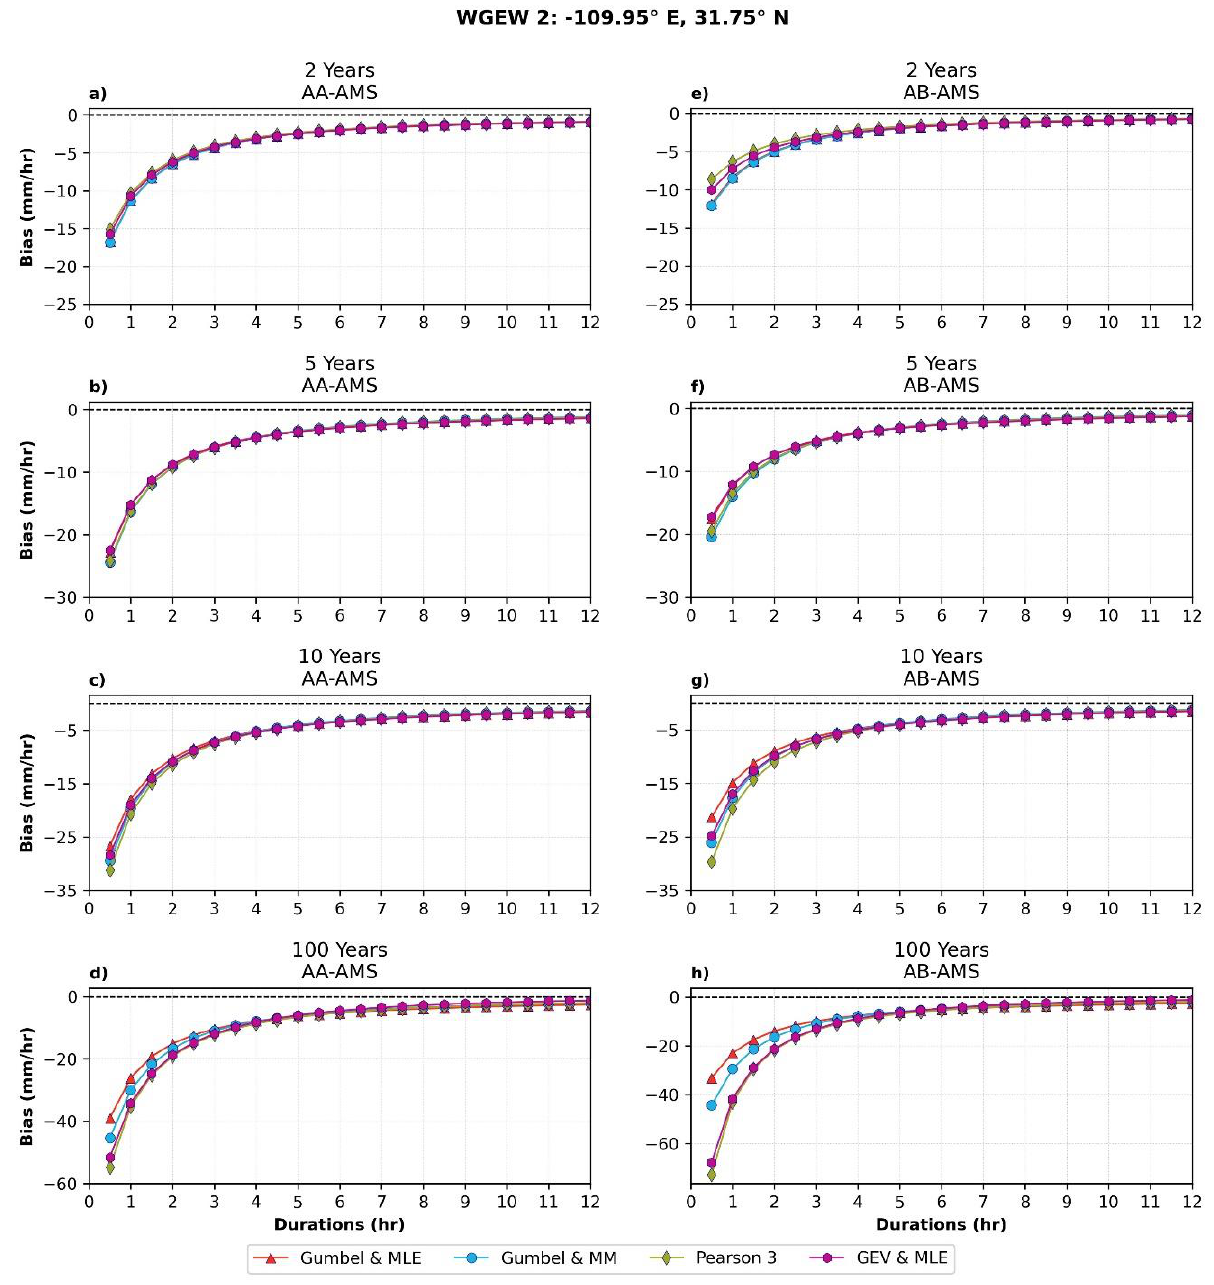
Figure A11. Precipitation intensity biases between IMERG IDFs and the gauge-based IDFs for 2, 5, 10, and 100 year return periods and event durations between 0.5 and 12 h over the WGEW 2. IMERG IDF vs. AA-AMS IDF ( left ) and IMERG IDF vs. AB-AMS IDF ( right ).